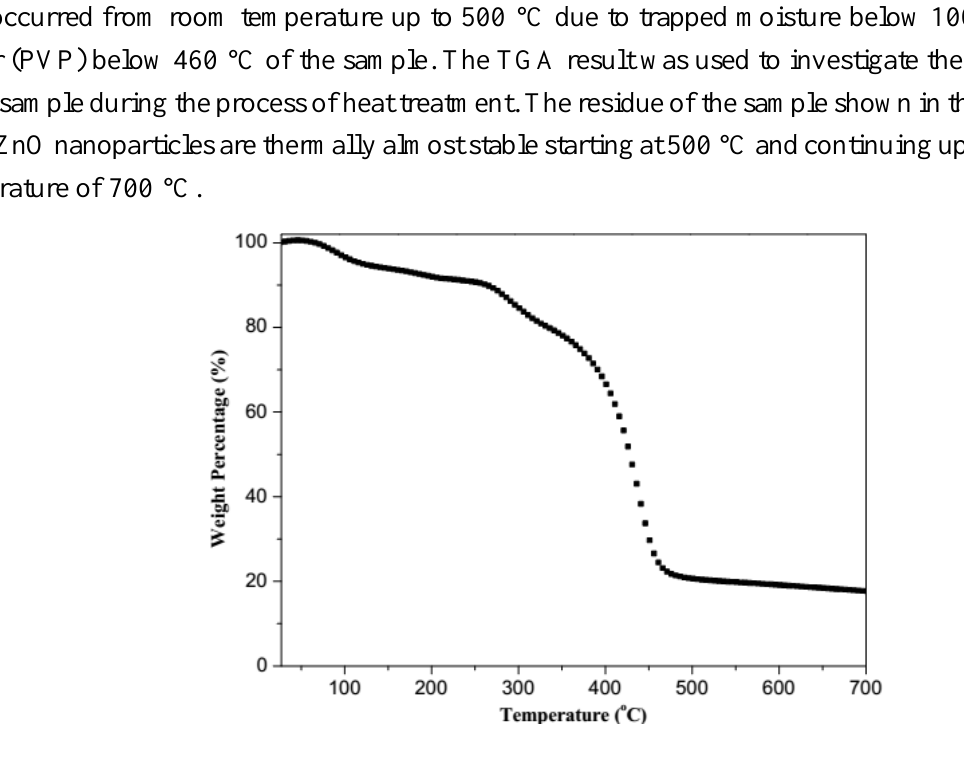
Figure 1. TGA analysis of as-prepared